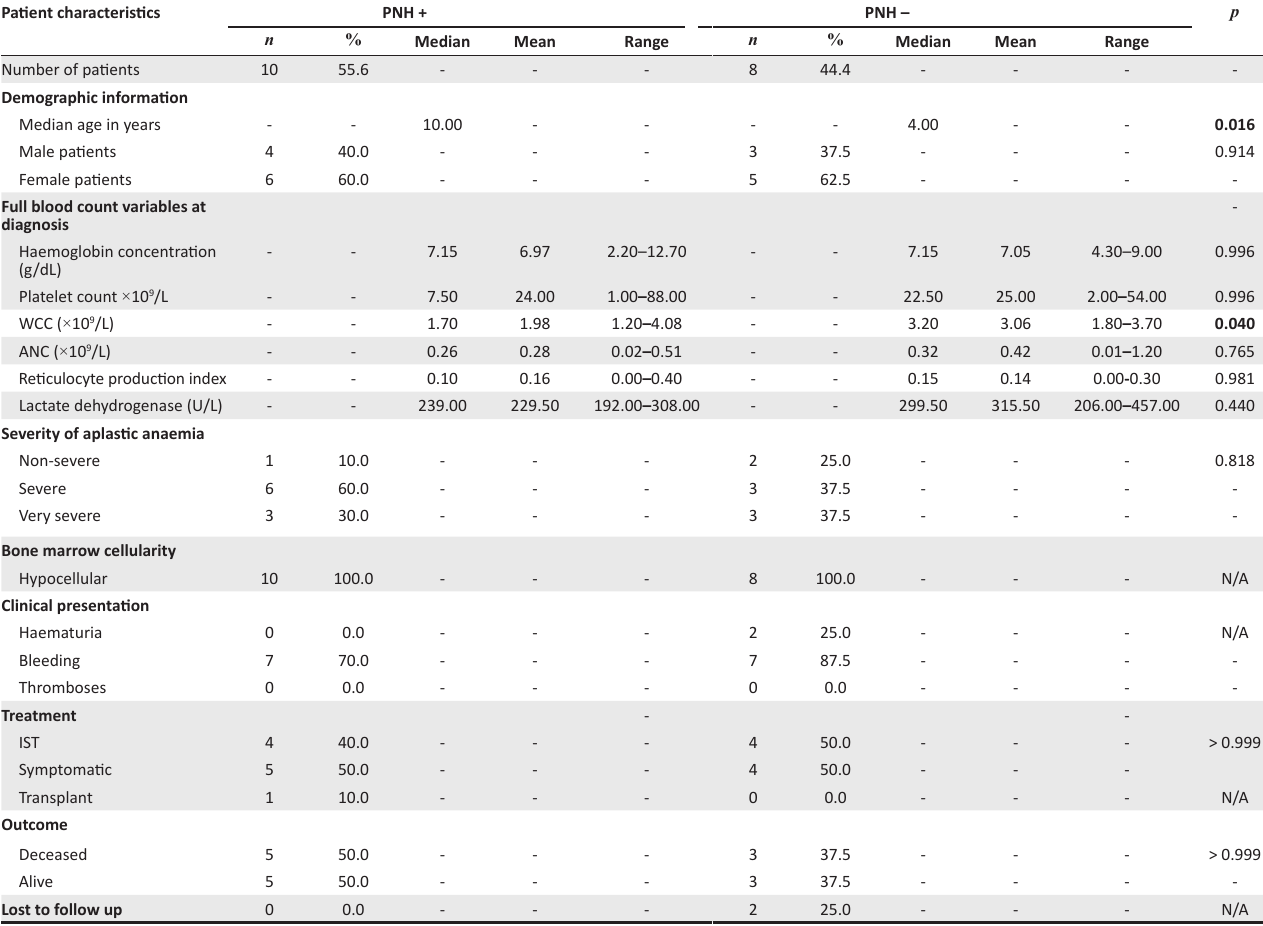
TABLE 1: Clinical characteristics of paroxysmal nocturnal haemoglobinuria-positive and -negative patients at the Inkosi Albert Luthuli Central Hospital, Durban, South Africa, September 2013 – January 2018. Patient